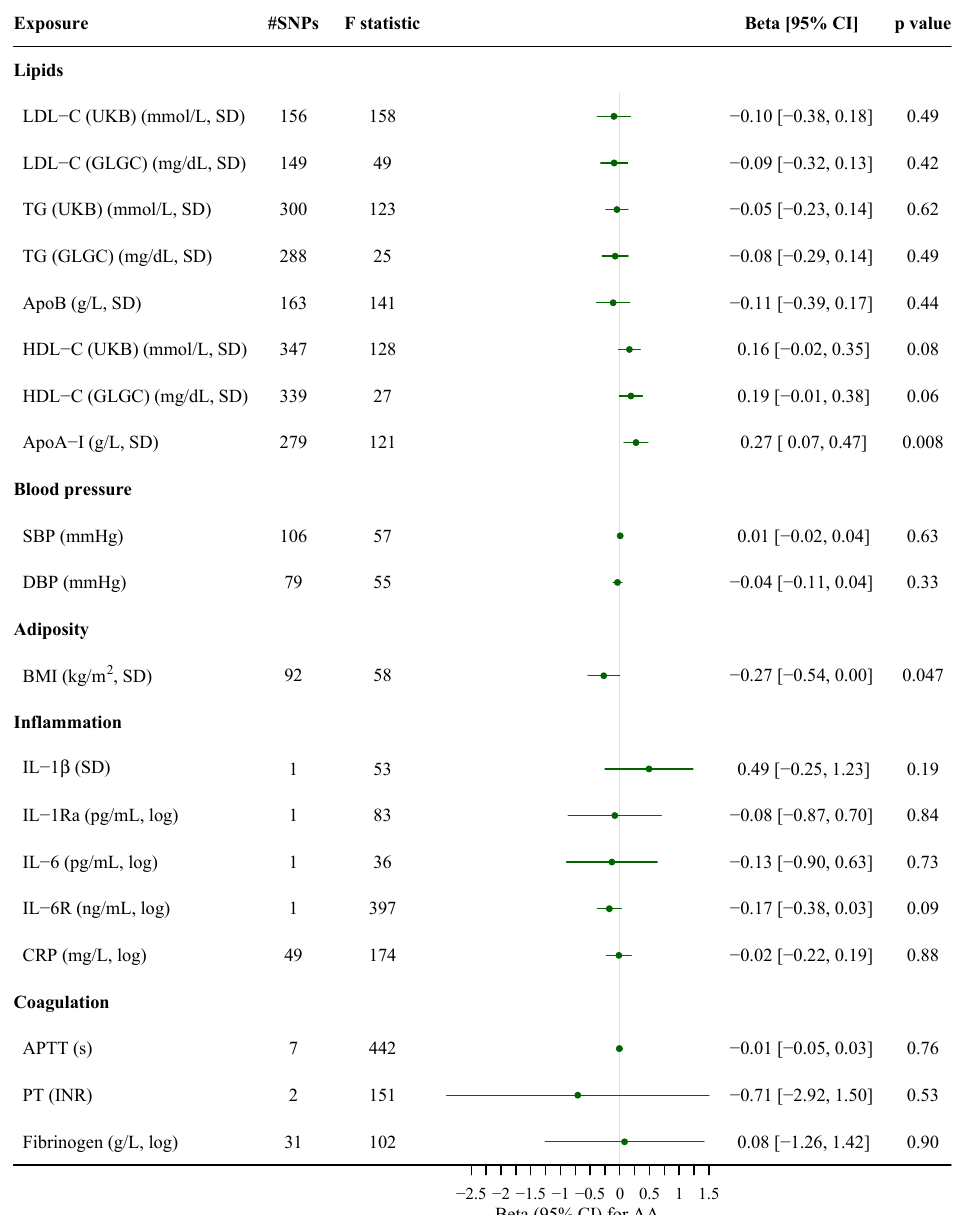
Figure 2. Associations of genetically predicted lipid profile, blood pressure, adiposity, and markers of inflammation and coagulation with arachidonic acid synthesis. The estimates based on two or more SNPs were derived from inverse variance weighting with multiplicative random effects, while the estimates based on one SNP were the Wald estimate. ApoA-I, apolipoprotein A-I; ApoB, apolipoprotein B; APTT, activated partial thromboplastin time; BMI, body mass index; CI, confidence interval; CRP, C-reactive protein; DBP, diastolic blood pressure; GLGC, the Global Lipids Genetics Consortium; HDL-C, high-density lipoprotein cholesterol; IL-6, interleukin-6; IL-6R, IL-6 receptor; INR, international normalized ratio; LDL-C, low-density lipoprotein cholesterol; PT, prothrombin time; SBP, systolic blood pressure; SNP, single-nucleotide polymorphisms; TG, triglycerides; UKB, UK Biobank.